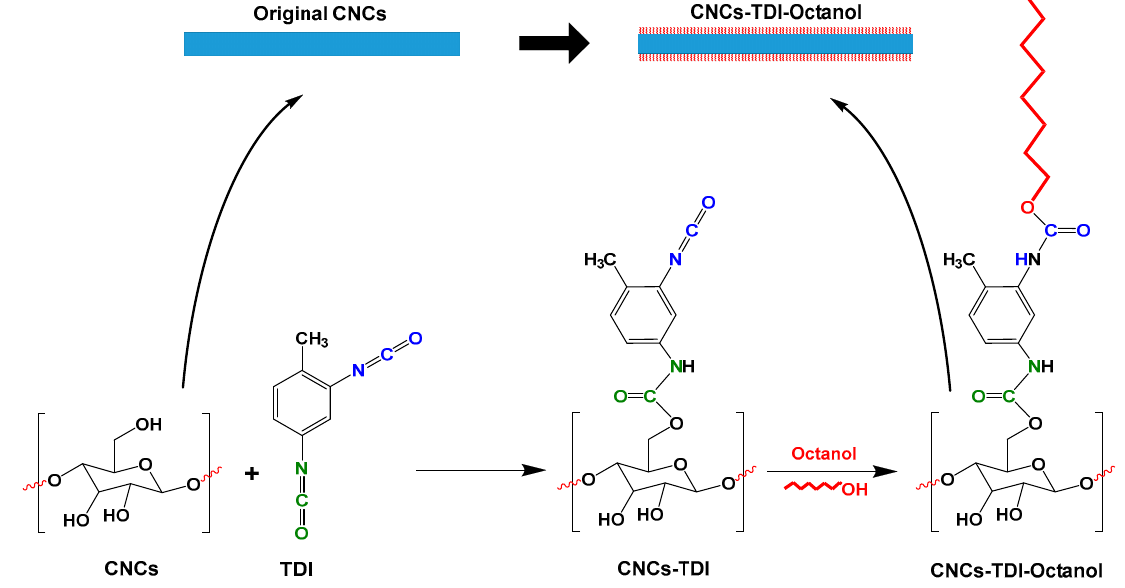
Figure 1. The proposed approach to tailor the hydrophilicity of cellulose nanocrystals (CNCs) by grafting alcohols of different chain lengths on the CNC surface using 2,4-toluene diisocyanate (TDI) as a linker.